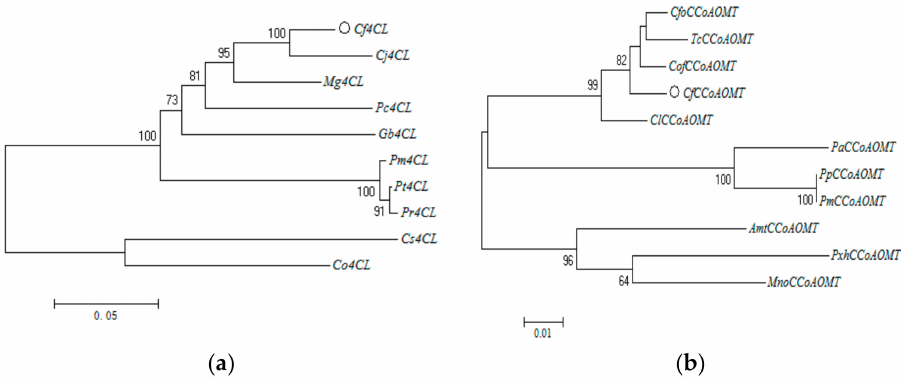
Figure 4. Phylogenetic trees of 4CL ( a ) and CCoAOMT ( b ) proteins using the most closely related protein sequences from 9 ( a ) and 10 ( b ) plant species. Displayed are tree diagrams of the interrelationships between the branches of each biological lineage, constructed according to their phylogeny to indicate the genetic relationship between species. Trees were generated using the unrooted Maximum Likelihood algorithm trees with MEGA 6.0 software. Bars represent genetic